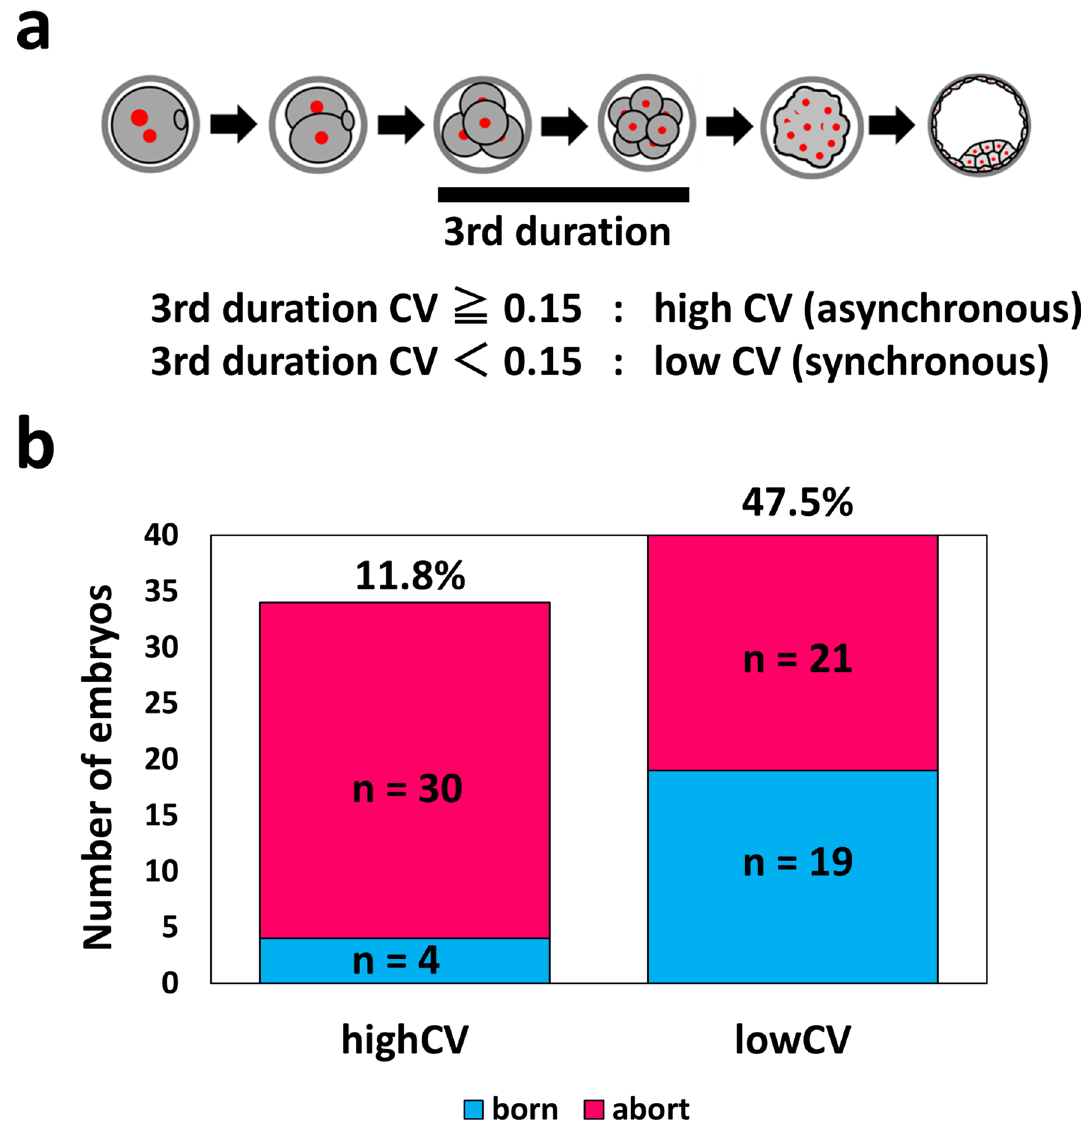
Figure 4. Prospective analysis by embryo selection and embryo transfer of asynchronous/synchronous embryos. ( a ) Scheme diagram for embryo selection. ( b ) Graph of transplantation results after embryo selection. For the prospective study, 74 mouse zygotes (we used 15 female and three male mice) were transferred. Born: n = 23 Abort: n =